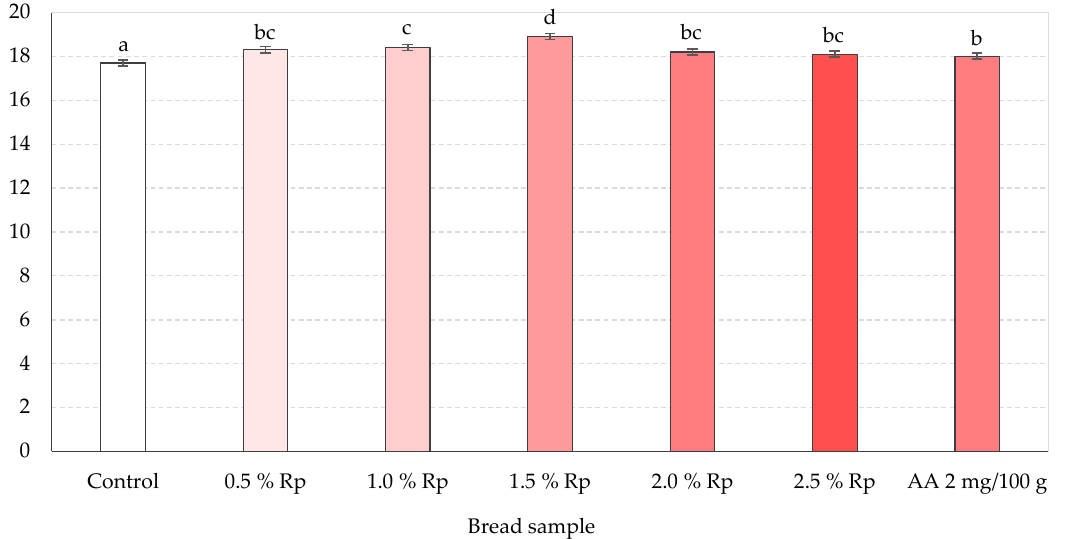
Figure 7. Sensory pro fi le of bread with Rp addition based on the 20-point test.